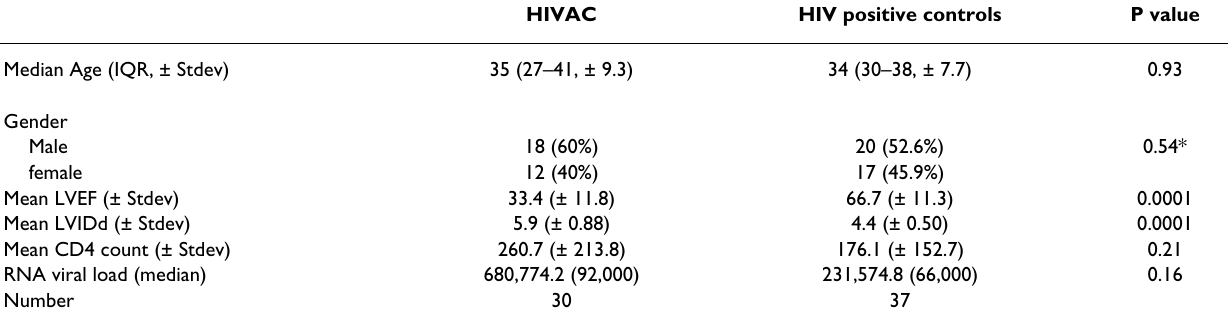
Table 1: Clinical characteristics of the HIV-associated cardiomyopathy cases and HIV-positive controls